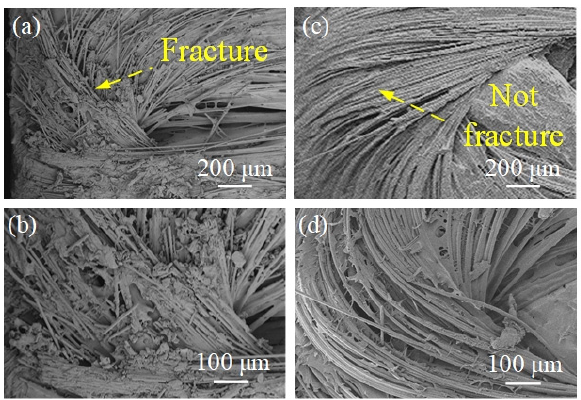
Figure 6. SEM micrographs of fiber U-turn: ( a , b ) carbon fibers, ( c , d ) Kevlar fibers.